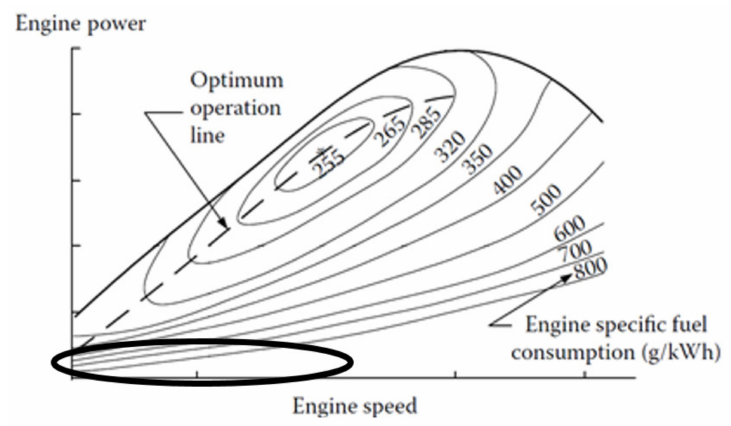
Figure 1. Specific fuel consumption map of a typical internal combustion engine.